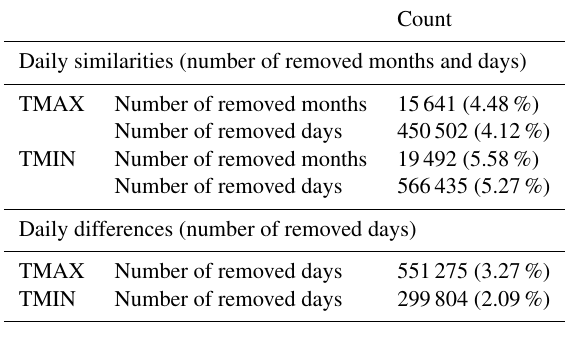
Table 1. Number of removed days and complete months based on the quality control criteria.